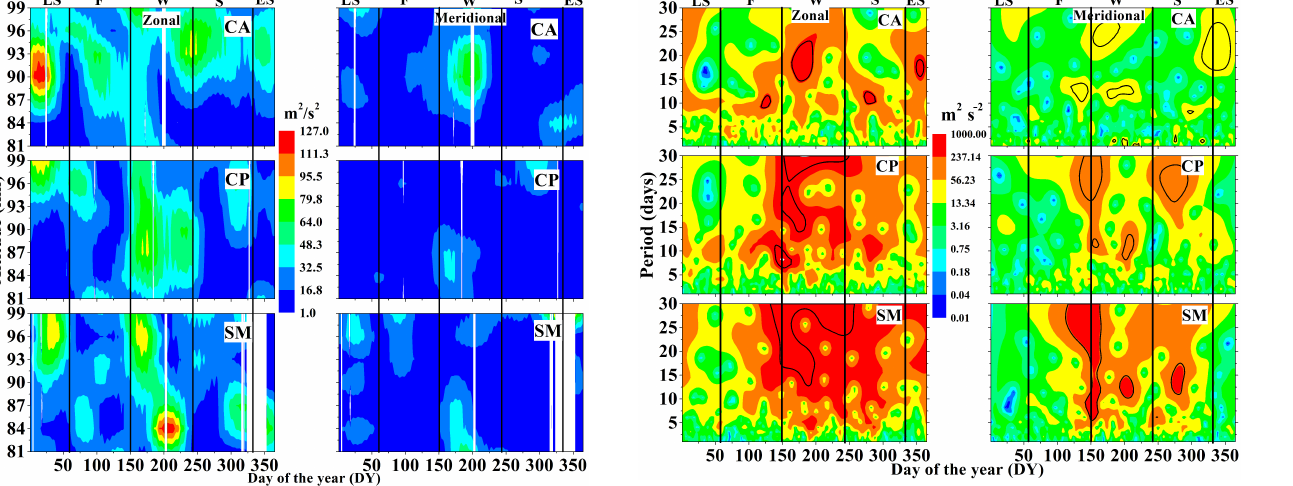
Figure 2. QSDW variance in the MLT estimated from the zonal and meridional winds for the three locations.